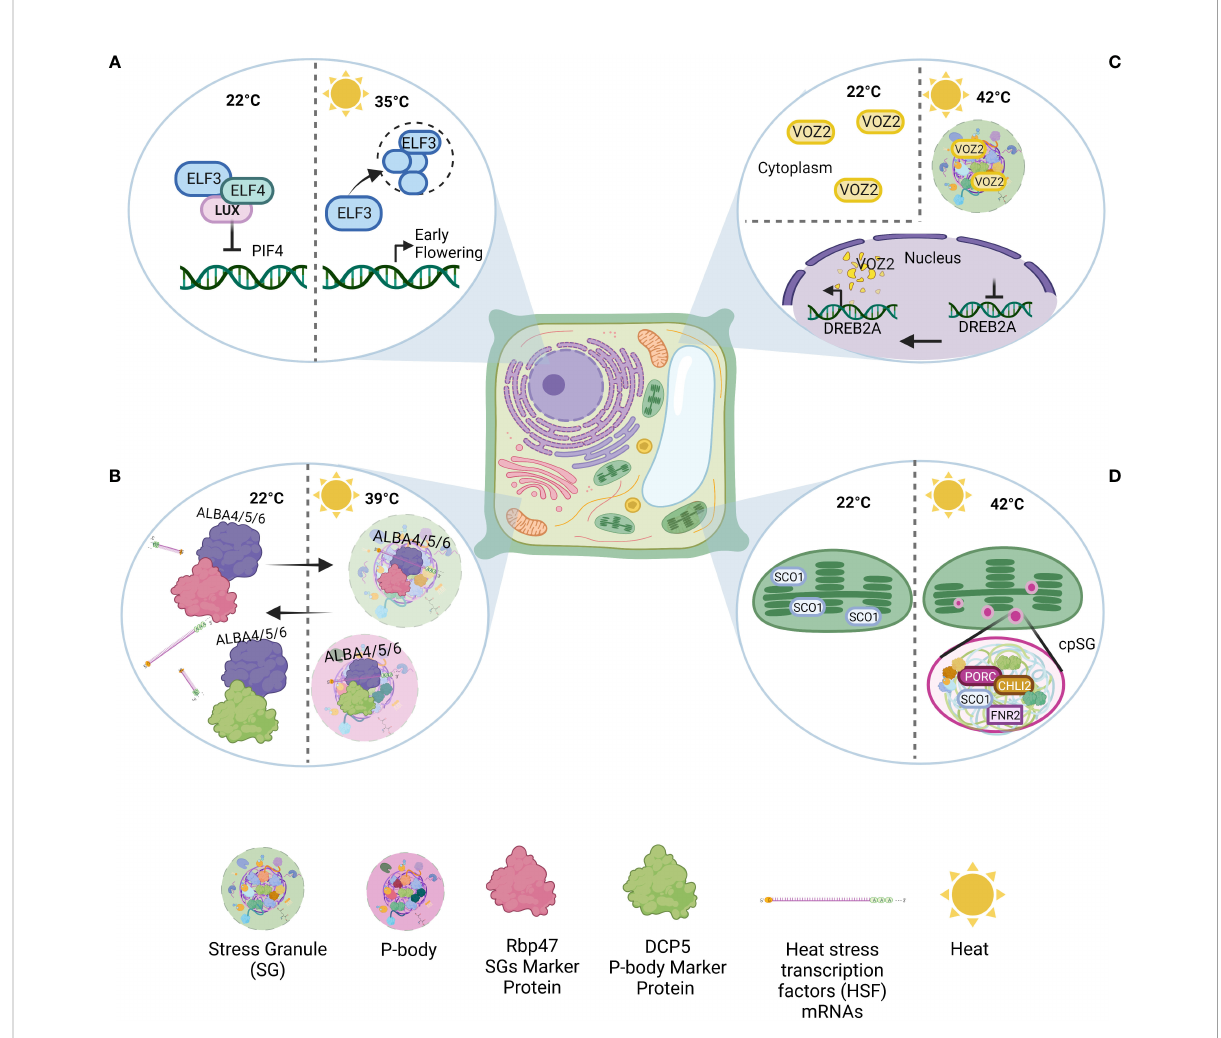
FIGURE 1 Examples of condensates formed in Arabidopsis thaliana under heat. (A) ELF3 nuclear condensate: Under normal conditions, ELF3, ELF4, and LUX ARRHYTHMO (LUX) form the EVENING COMPLEX (EC), a repressor of various genes. In response to high temperatures (warming, 35°C), ELF3 condensation causes EC disassociation, target gene activation, and subsequent early fl owering. (B) ALBA-SGs: Under normal conditions, ALBA4, ALBA5, and ALBA6 can interact with Rbp47 and DCP5. Under heat shock (39°C), ALBA acts as a scaffold to stress granule and P-body assembly. At the same time, ALBA binds and stabilizes HSF mRNAs to protect them from degradation. (C) VOZ2-SGs: VOZ2 is dispersed throughout the cytosol under normal conditions. During heat stress (42°C), VOZ2 is transferred to the nucleus, inhibiting certain genes (e.g., DREB2). Meanwhile, in the cytoplasm, VOZ2 colocalizes with SGs and partially with P-bodies. However, nuclear VOZ2 is degraded after two hours. (D) cpSGs: Heat stress (42°C) can induce cpSG formation. The proteomics/sequence analysis revealed the presence of 88 proteins in cpSGs (e.g., FNR1, PORC, and